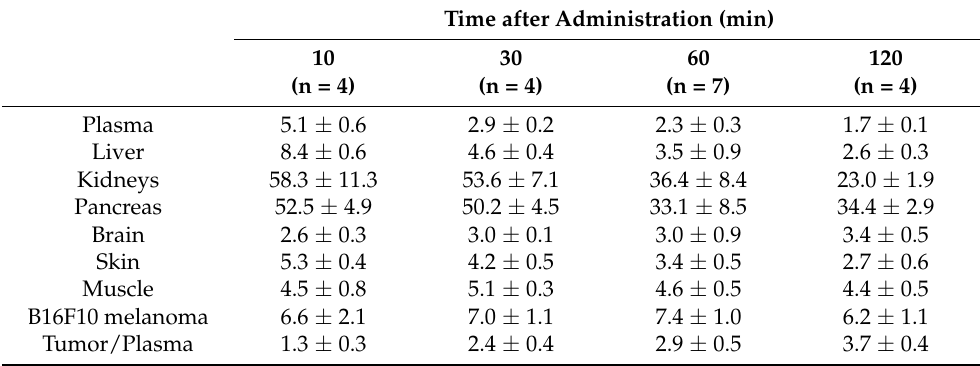
Table 2. Biodistribution of boron concentration after administration of 3-BPA-Fru in melanoma- bearing mice (%ID/g, n = 19).